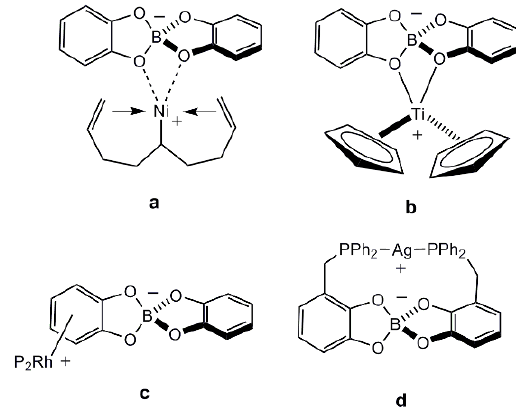
Figure 1. Metal complexes containing arylspiroboronate